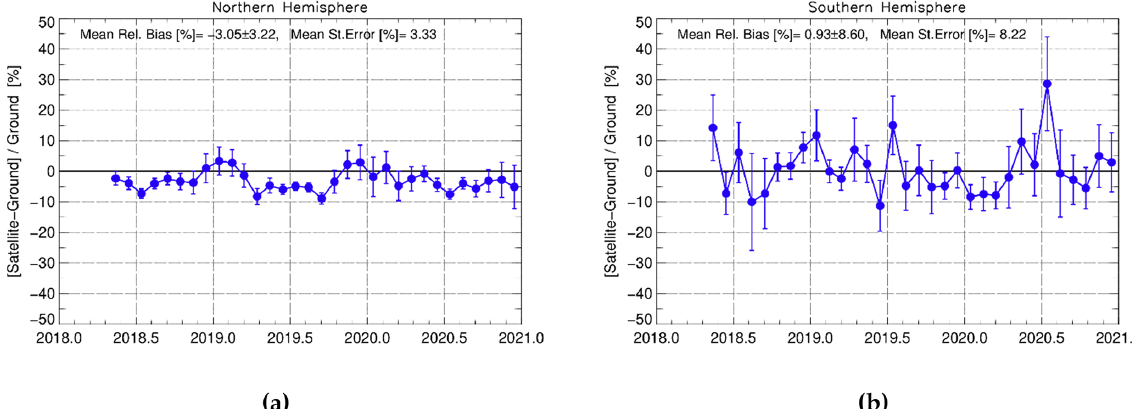
Figure 7. The time series of the monthly mean relative differences between TROPOMI/S5P TCWV and ground-based AERONET measure- ments, shown for the Northern (a) and the Southern Hemisphere (b) . The error bars stand for the standard error of the mean with a confidence interval (CI) of